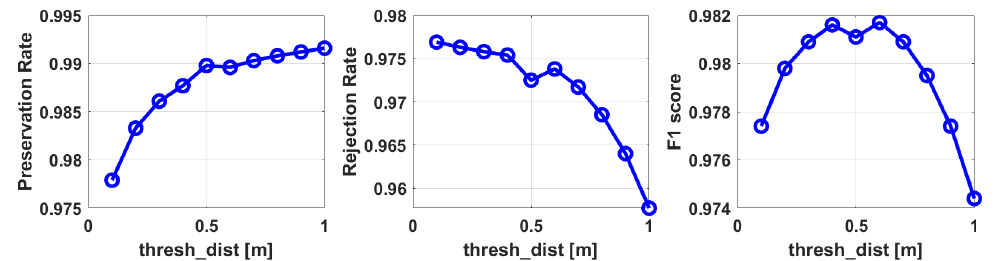
Figure 16. Map cleaning performance under different thresh _ dist values.